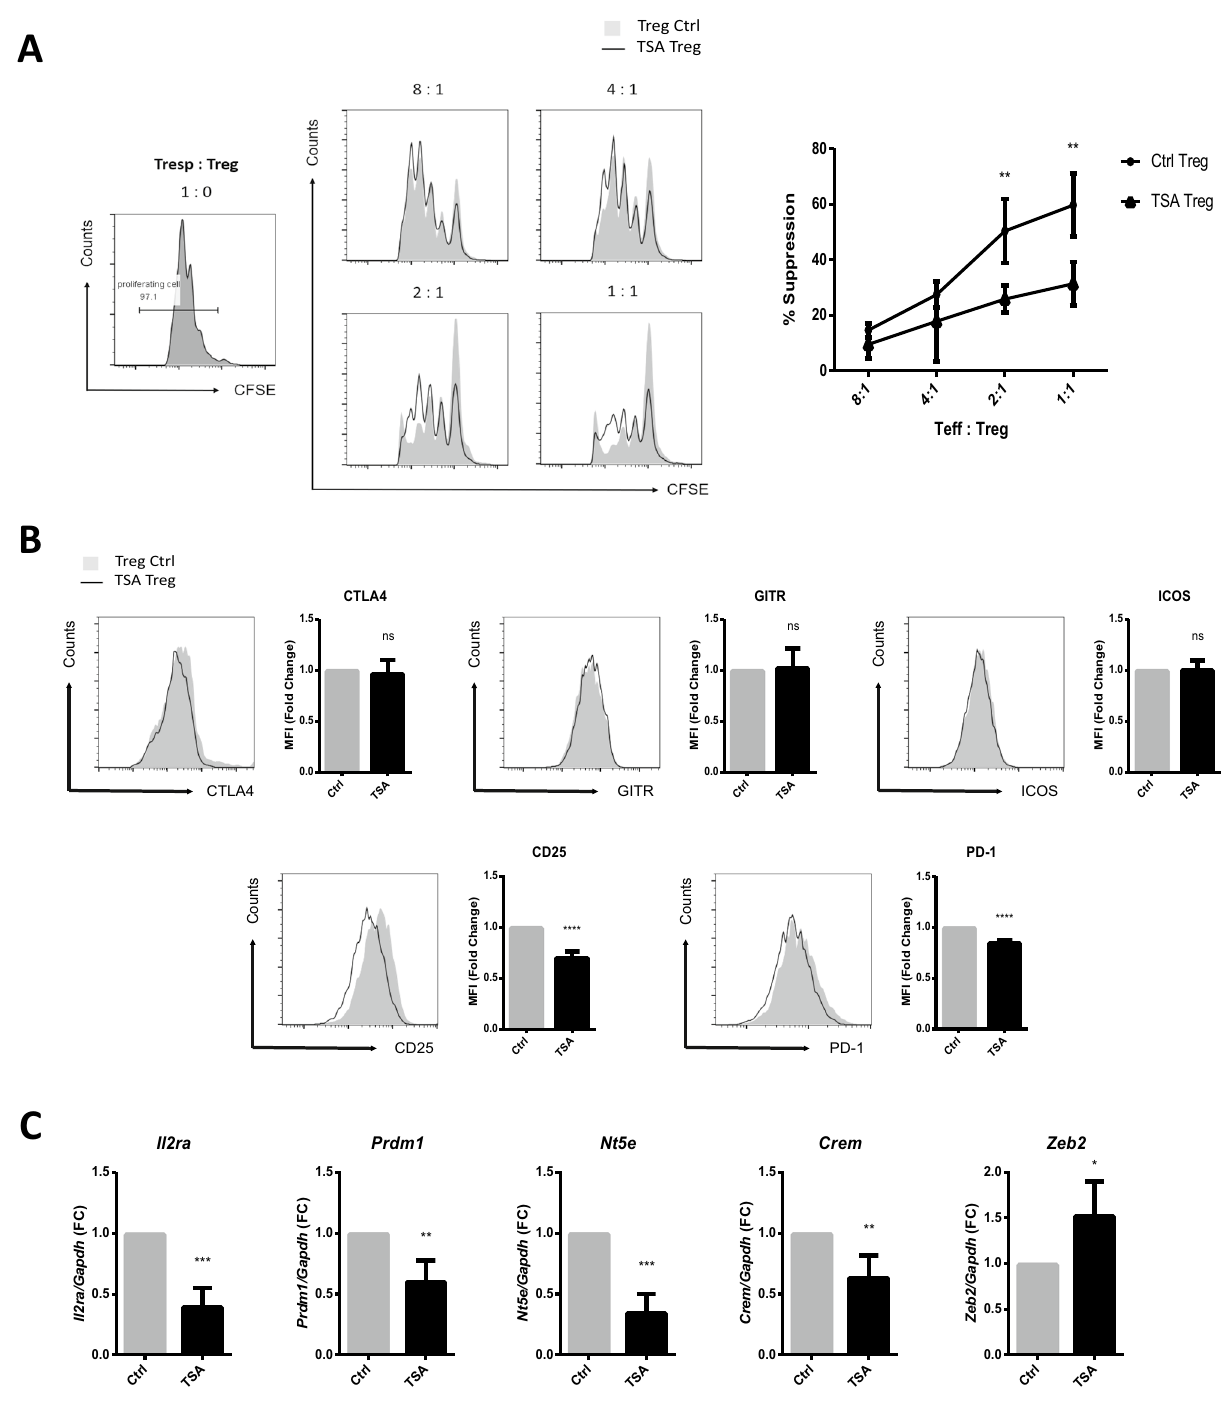
Figure 5. An HDAC6 inhibitor reduces iTreg cell proliferation. ( A ) Naïve CD4 + T cells were stained with CFSE and cocultured with the indicated ratios of Treg cells. The in vitro immunosuppressive activity of Treg cells was quantified by analyzing proliferation of naïve CD4 + T cells. Histogram data are representative of three independent experiments, and statistical analysis was performed using data pooled from three independent experiments. ( B ) Naïve CD4 + T cells were differentiated for 3 days into Treg cells in the presence of vehicle (control) or TSA (10 μM). Expression of CTLA4, GITR, ICOS, CD25, and PD-1 protein was analyzed by flow cytometry. The MFI for each experiment was measured and data from four independent experiments were pooled. ( C ) Cells were cultured as described in B. Expression of Il2ra, Prdm1, Nt5e, Crem, and Zeb2 mRNA was measured by qRT-PCR. qRT-PCR data from four independent experiments were pooled. Error bars represent the SD, and P values were determined by a two-way ANOVA (A) and the Student’s t test ( B , C ). * P < 0.05; ** P < 0.01; *** P < 0.001; and **** P < 0.0001, n.s., not